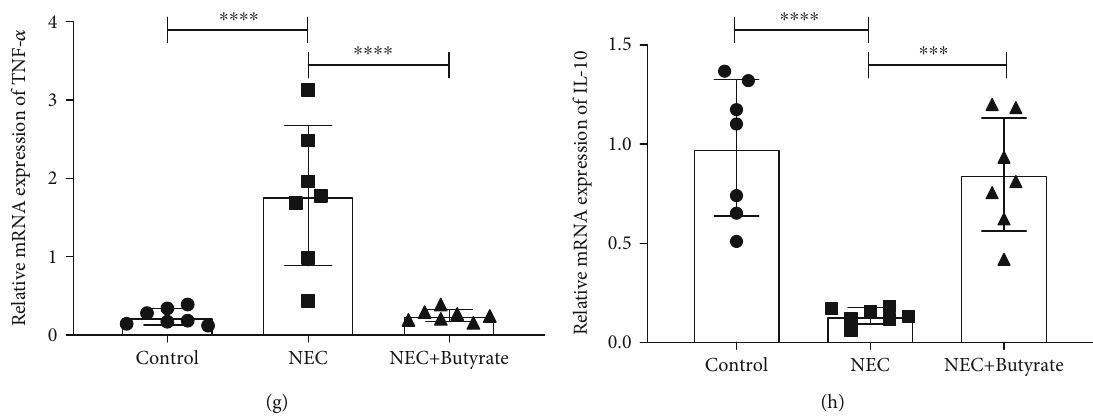
Figure 3: The relative mRNA expression of in fl ammatory cytokines in the three groups: (a) TLR4; (b) NF- κ B; (c) HMGB1; (d) IL-1 β ; (e) IL- 6; (f) IL-8; (g) TNF- α ; (h) IL-10. Number of samples: control ( n = 7 ), NEC ( n = 7 ), and NEC+butyrate ( n = 7 ). Statistical analysis: one-way ANOVA. ∗∗∗ P < 0 : 001 ; ∗∗∗∗ P < 0 : 0001